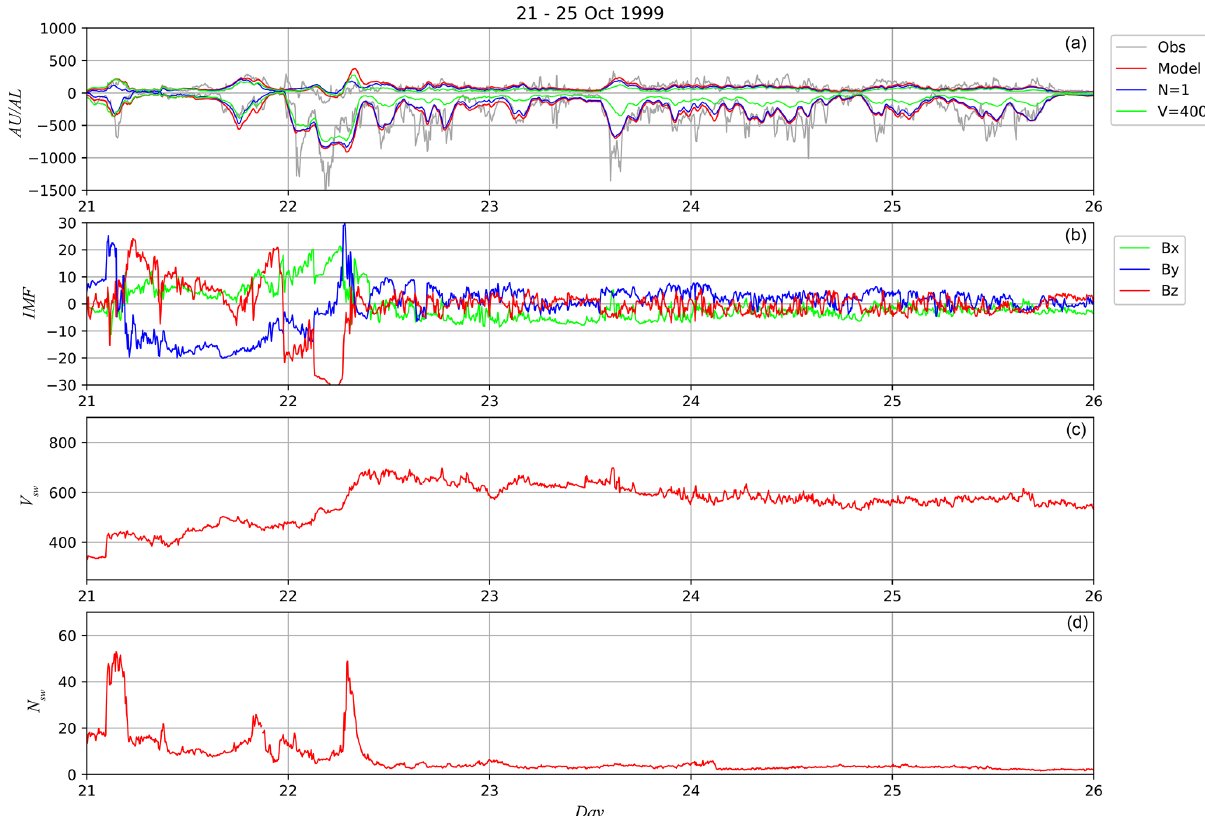
Figure 8. Comparison of some ESN outputs during the period from 21 October to 25 October 1999. Panel (a) shows the ESN output with all the parameters (red), the synthetic indices with the solar-wind speed effect turned off (green), those with the solar-wind density effect turned off (blue), and the observed AU and AL indices (gray). Panel (b) shows the IMF B x (green), B y (blue), and B z (red) in GSM coordinates. Panel (c) shows the solar-wind speed, the fourth panel shows the solar-wind density, and panel (d) shows the SYM-H